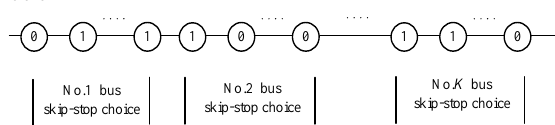
Fig. 5. The coding illustration of a chromosome for the inner genetic